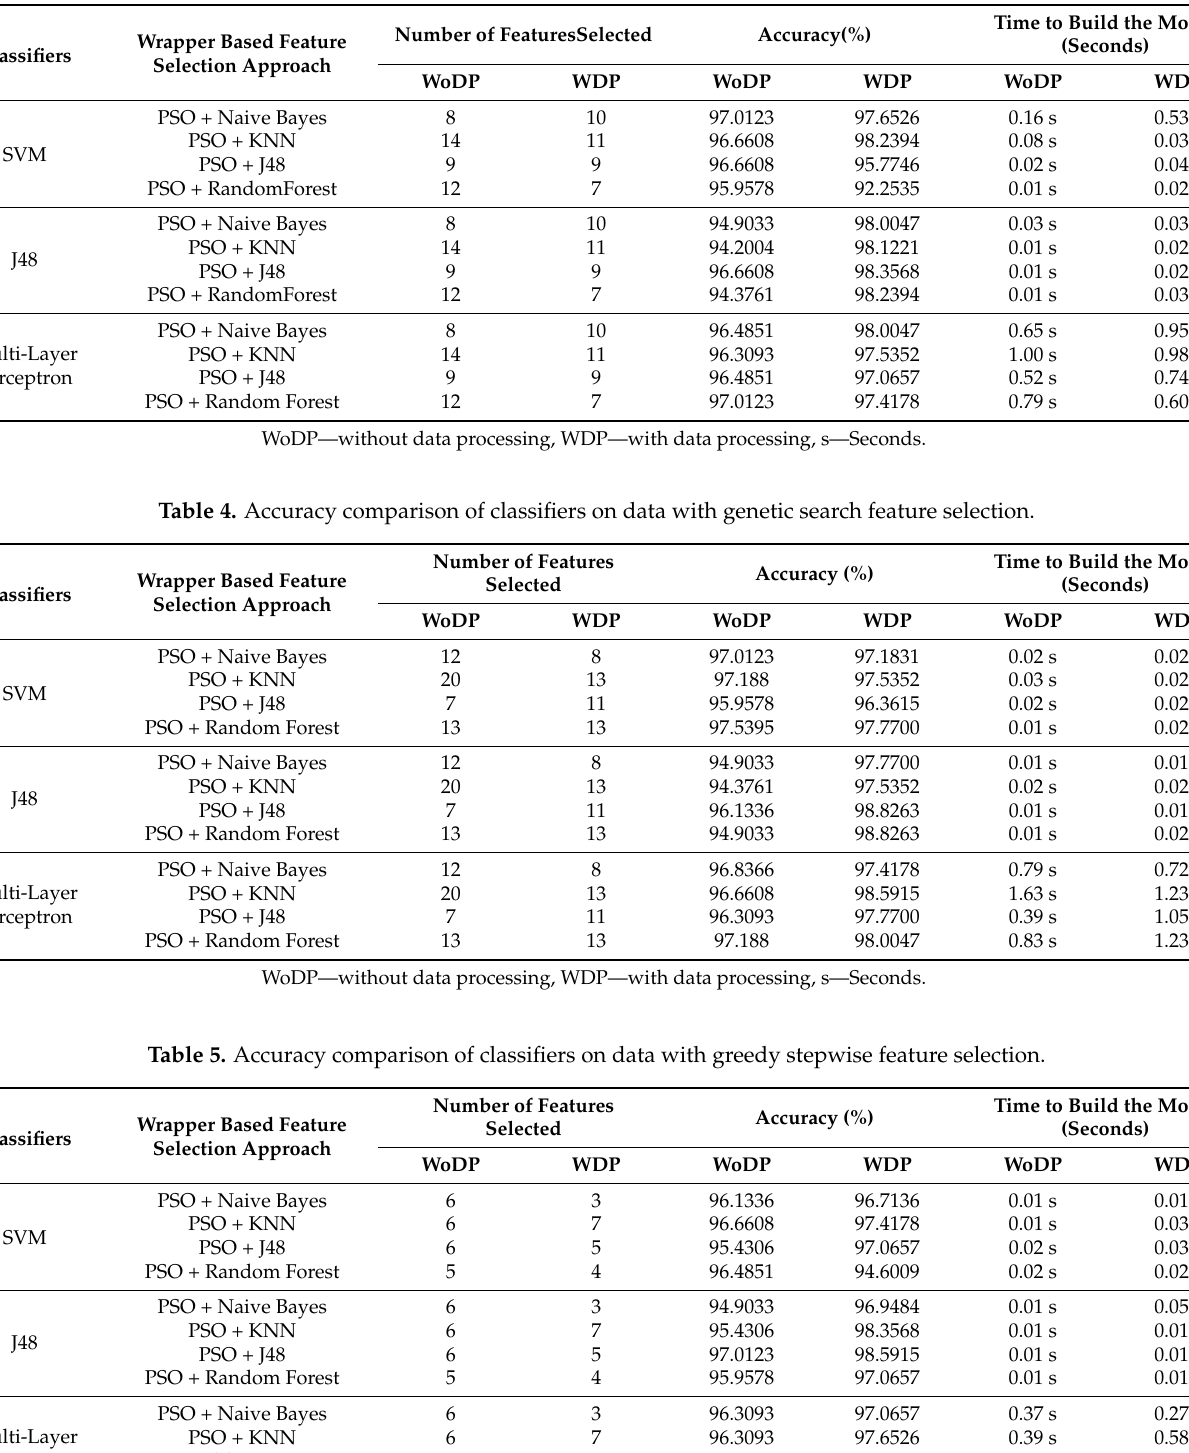
Table 3. Accuracy comparison of classifiers on data with particle swarm optimization (PSO) feature selection.